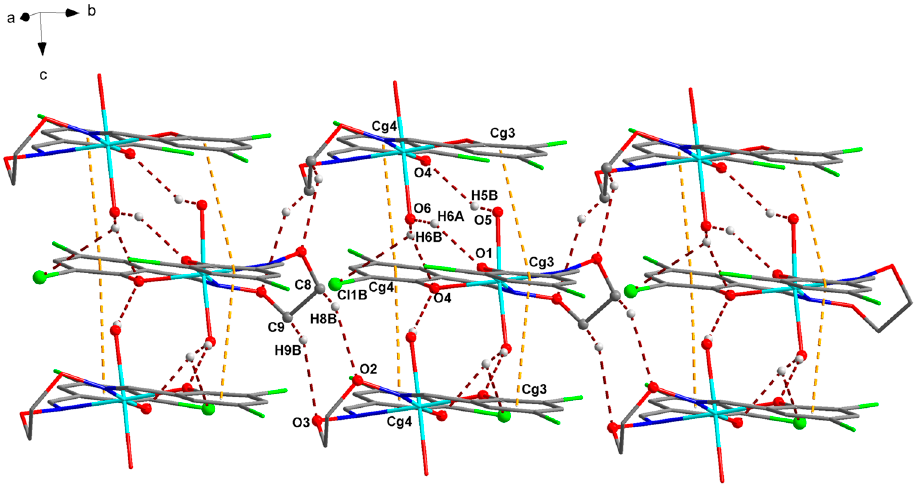
Figure 2. View of the 2D supramolecular structure of complex 1 showing the O–H···O, O–H···Cl hydrogen bonding and π – π stacking interactions.